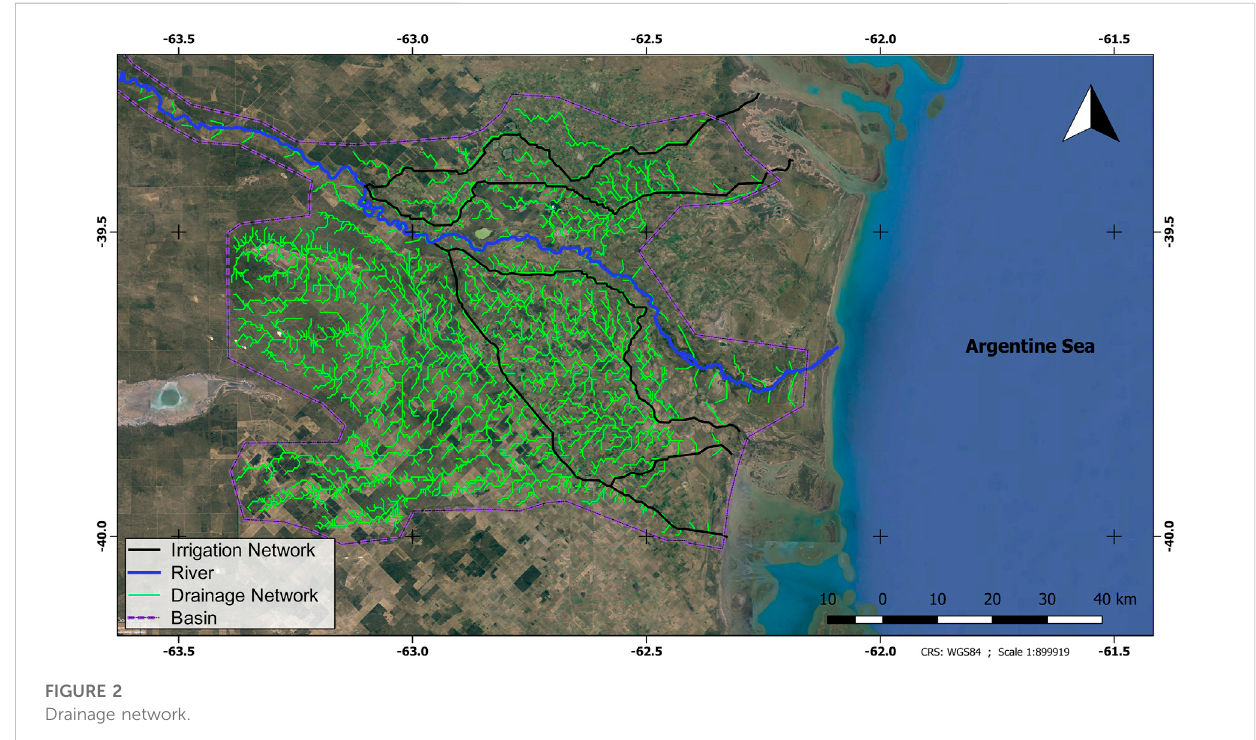
FIGURE 2 Drainage